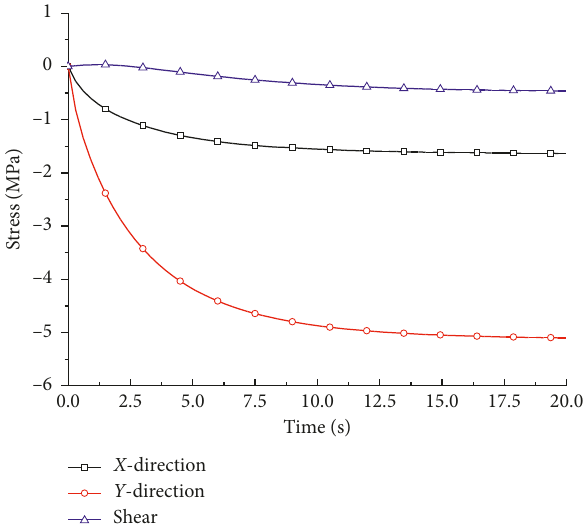
Figure 13: Stress curves of measurement point MP1 under the gravity force.